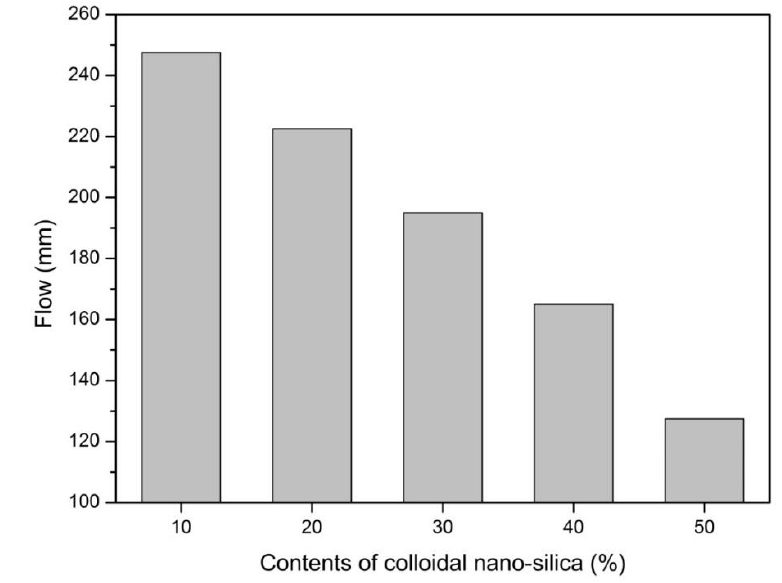
Figure 1. Flow values by CNS replacement rate.